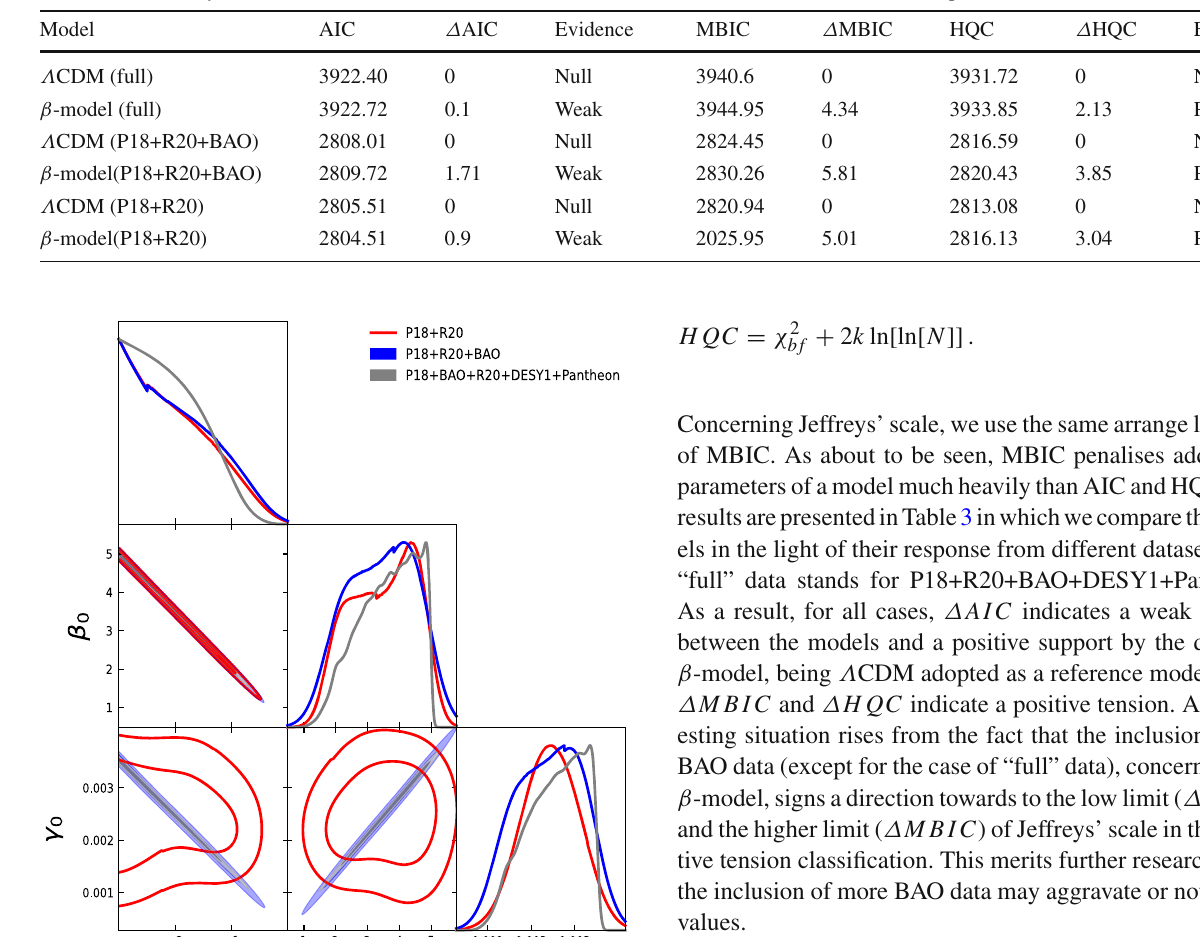
Table 3 A summary of the obtained values of AIC, MBIC and HQC for the studied models. Λ CDM is adopted as a reference model